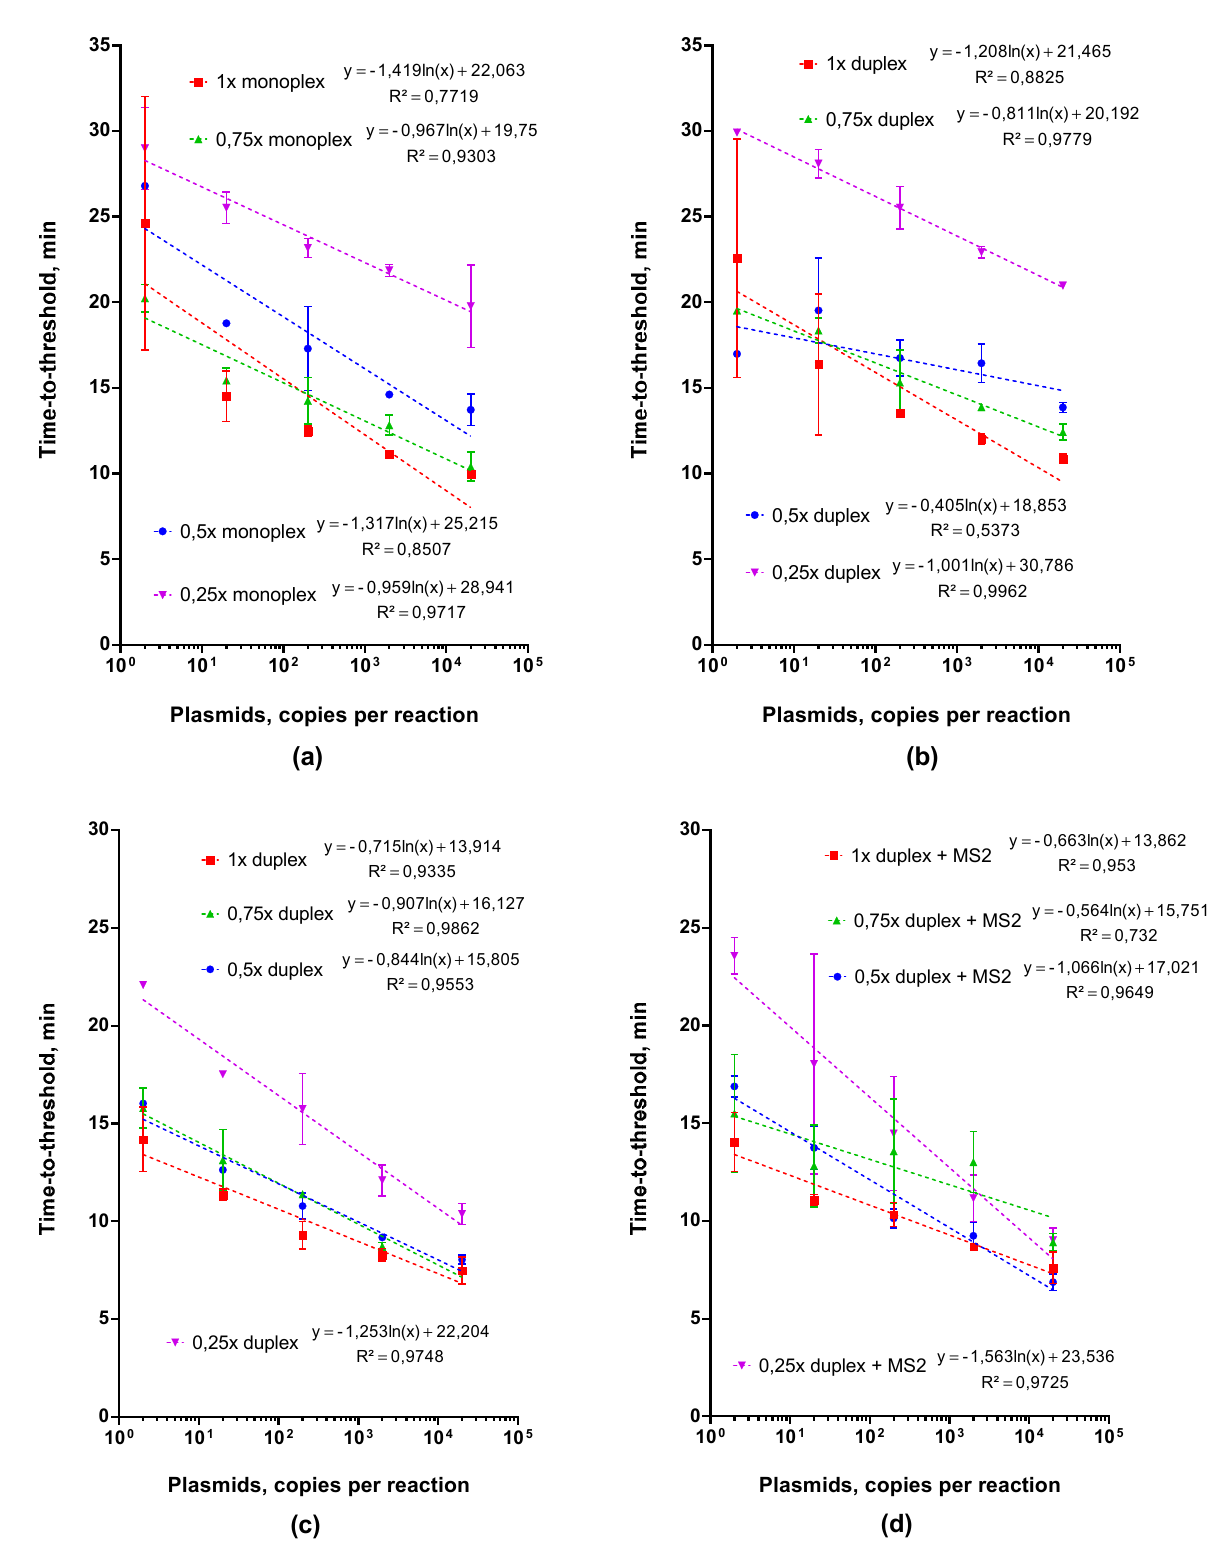
Figure 3. LAMP with plasmids and different concentrations of MS2 primers in ( a ) monoplex, ( b ) duplex, ( d ) duplex with MS2 RNA and ( c ) without it. Each MS2 primer concentration is marked by the color specified in the legend. Tt values are presented on the X-axis, and amount of template per reaction on the Y-axis. Each run was triplicated; error bars represent one SD.